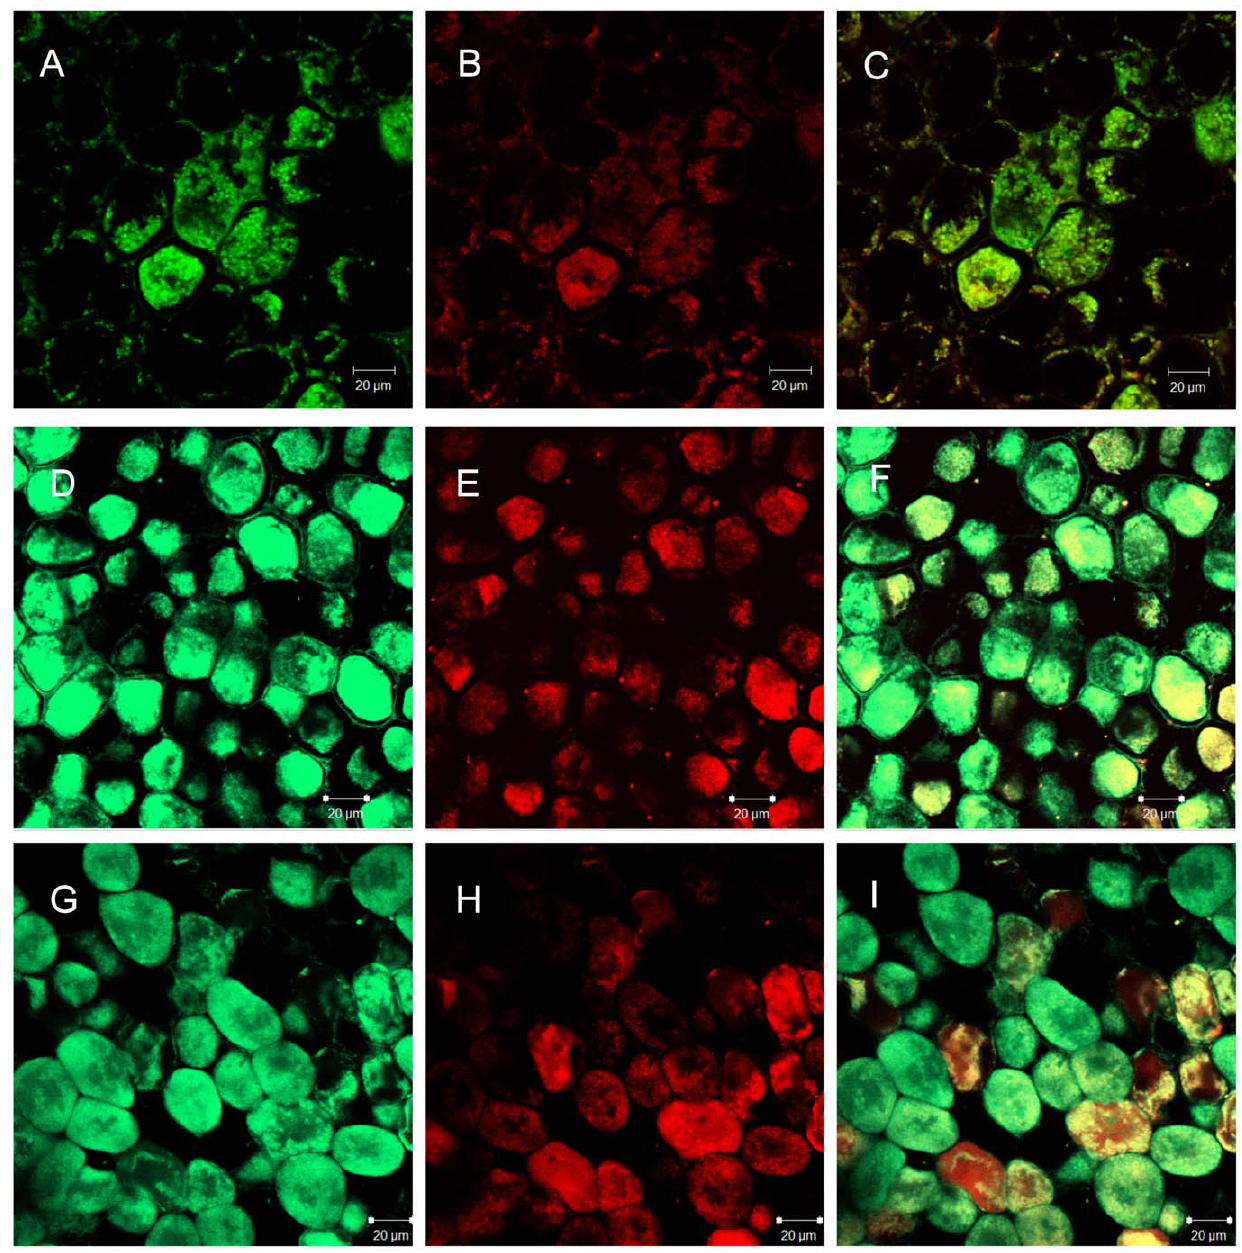
Figure 6. Colocalization of nitrosothiol (RSNO) and bacteroids in the A.hypogaea JL 24 nodules. 20 day (A, B, C), 40 day (D, E, F) and 80 day (G, H, I) old nodules cross sections were incubated in the presence of 10 m M Alexafluor 488 and 10 m M Syto83 at 25 u C for 2 hour in darkness and fluorescence were observed under confocal laser microscopy. Photographs are representative of results obtained from the analysis of nodules in three independent experiments. The fluorescence associated with (A), (D), and (G) was for RSNO detection and (B), (E) and (H) for bacteroids. (C), (F) and (I) are the overlaying corresponding images (A and B, D and E, G and H respectively). Scale bar=20 m m.